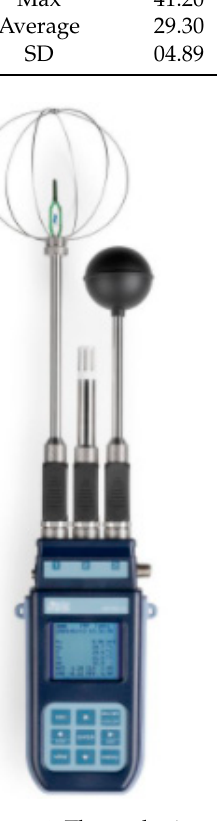
Figure 4. Thermal microclimate station.